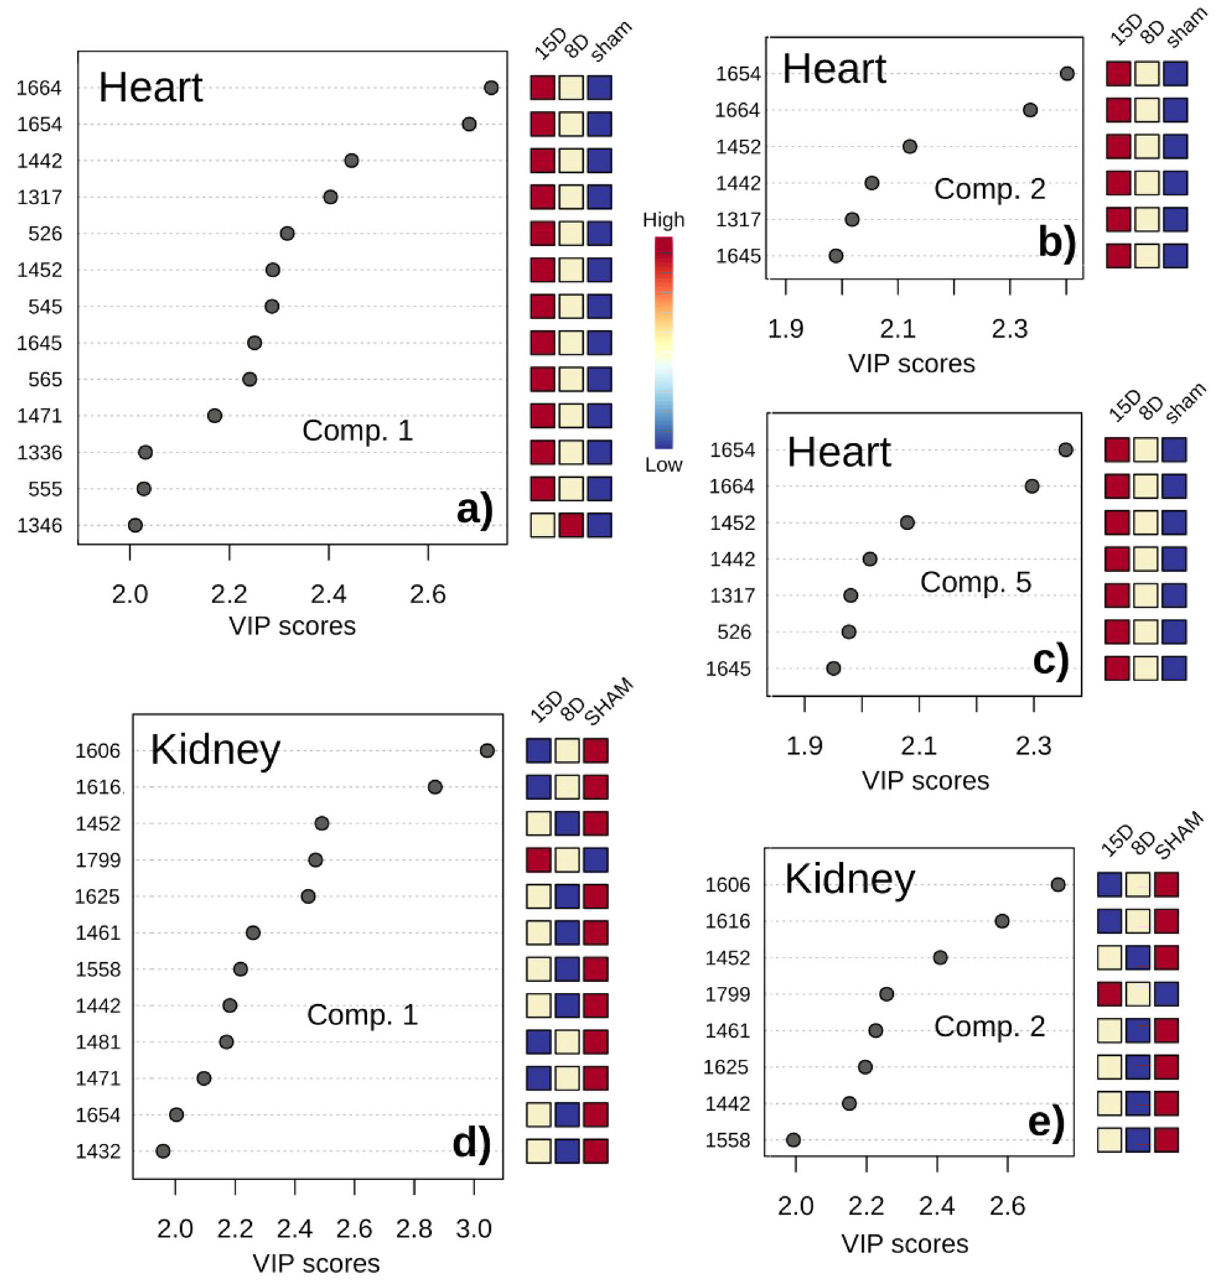
Figure 7. Important vibrational frequencies identified by PLS-DA for heart (components 1, 2, and 5 in a , b , and c , respectively) and kidney (components 1 and 2 in d and e , respectively). The colored boxes on the right indicate the relative intensity of the corresponding band in each group (Sham, 8D, and